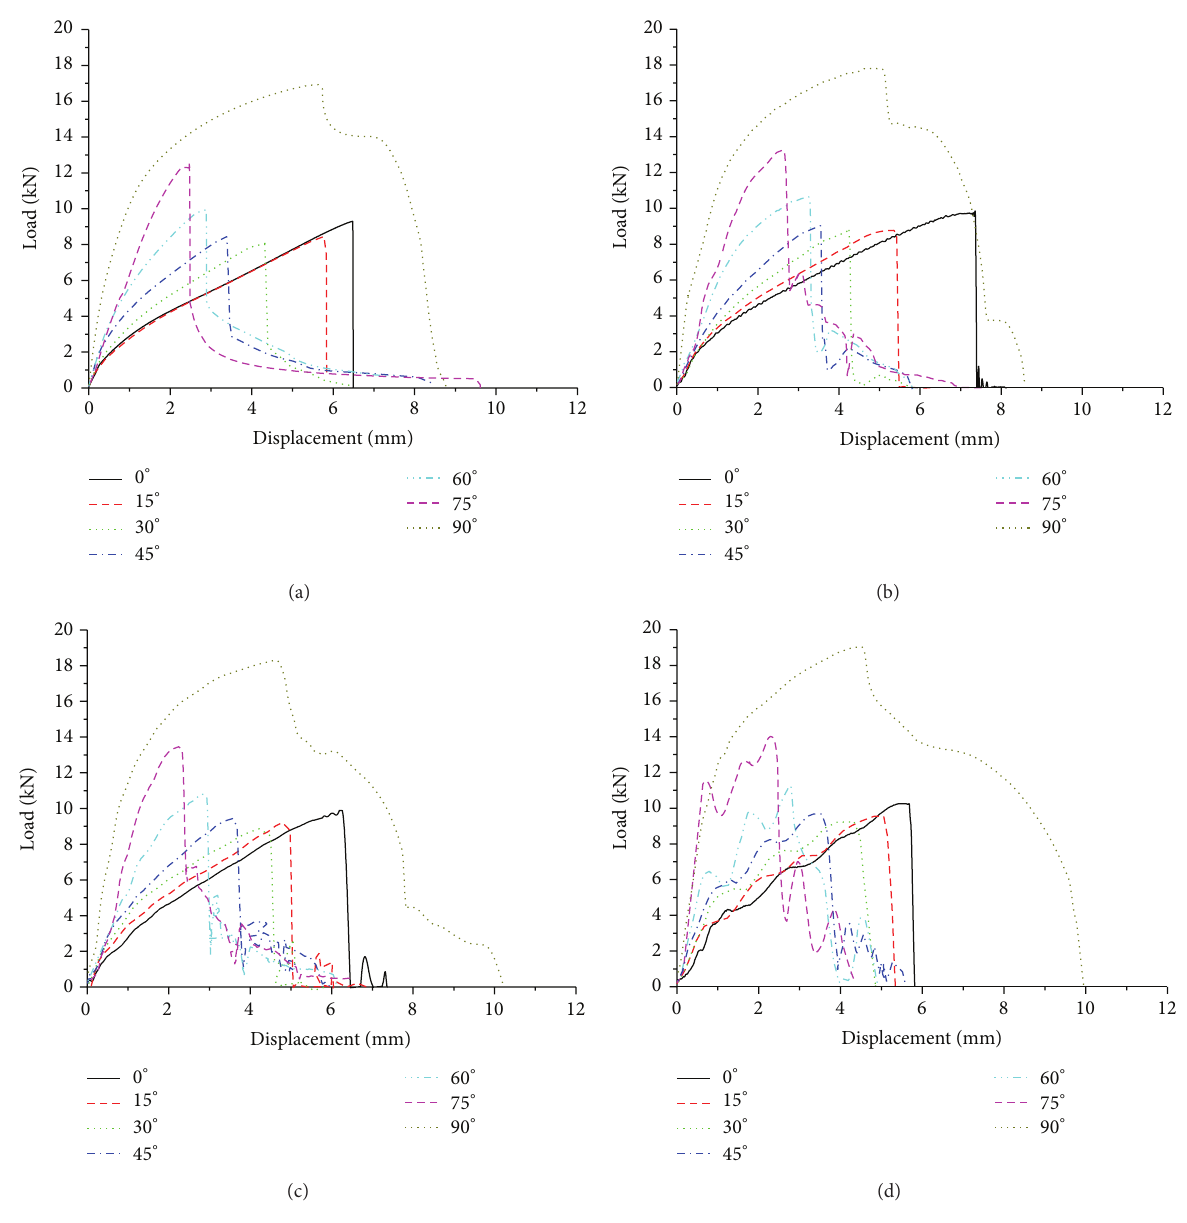
Figure 7: Load-displacement curves of spot-welded specimens for DP590 at various loading speeds: (a) quasi-static ( 1 × 10 −5 m/s); (b) dynamic (0.01 m/s); (c) dynamic (0.1m/s); (d) dynamic